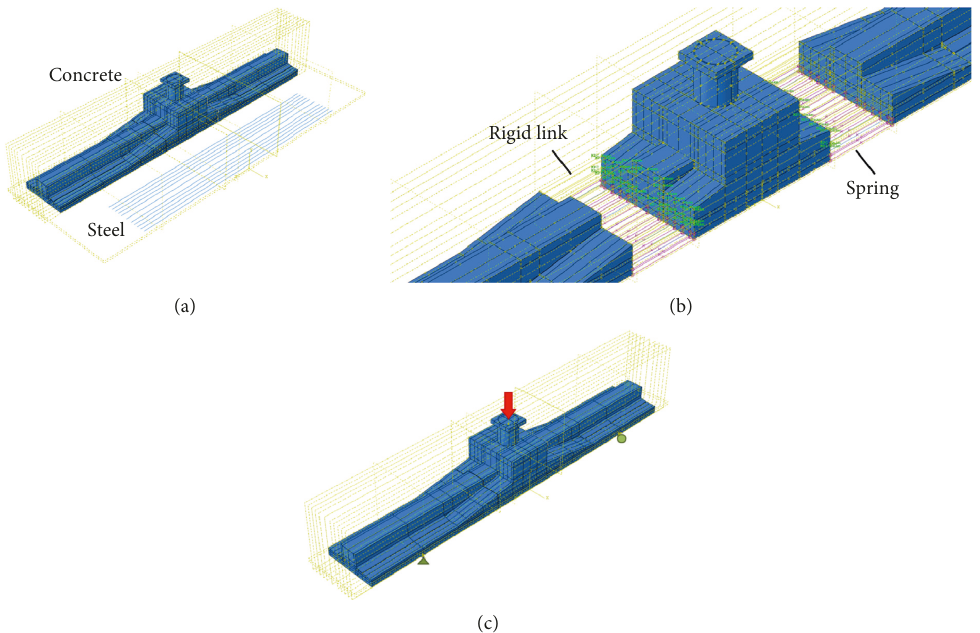
Figure 5: Finite element analysis. (a) Part modeling, (b) joint setup of analysis model, and (c) boundary condition.